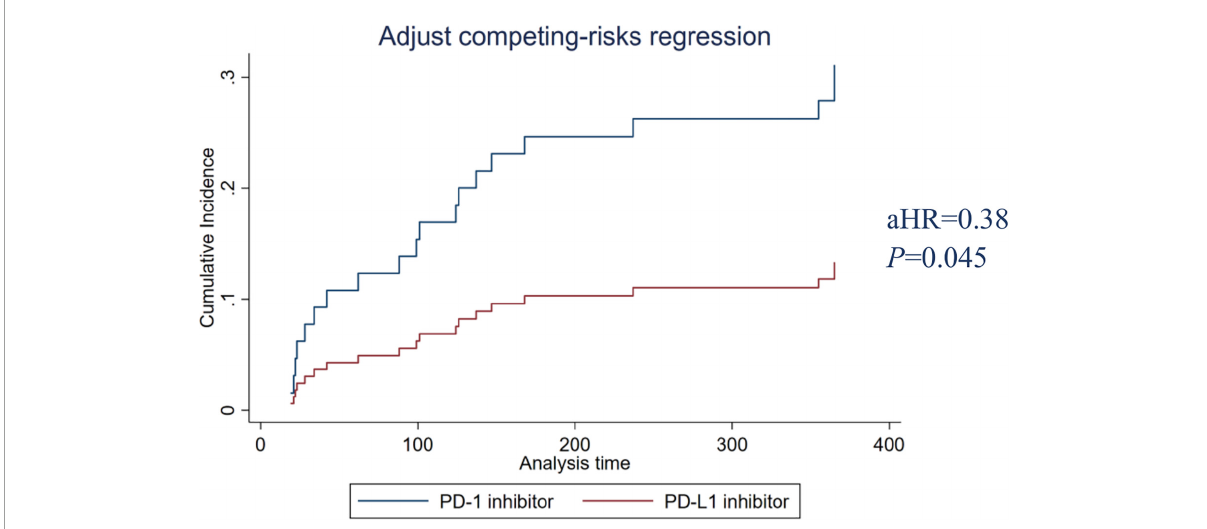
FIGURE4 PD-1 and PD-L1 inhibitors adjusted cumulative incidence rates. PD-1, programmed cell death protein 1; PD-L1, programmed cell death-ligand